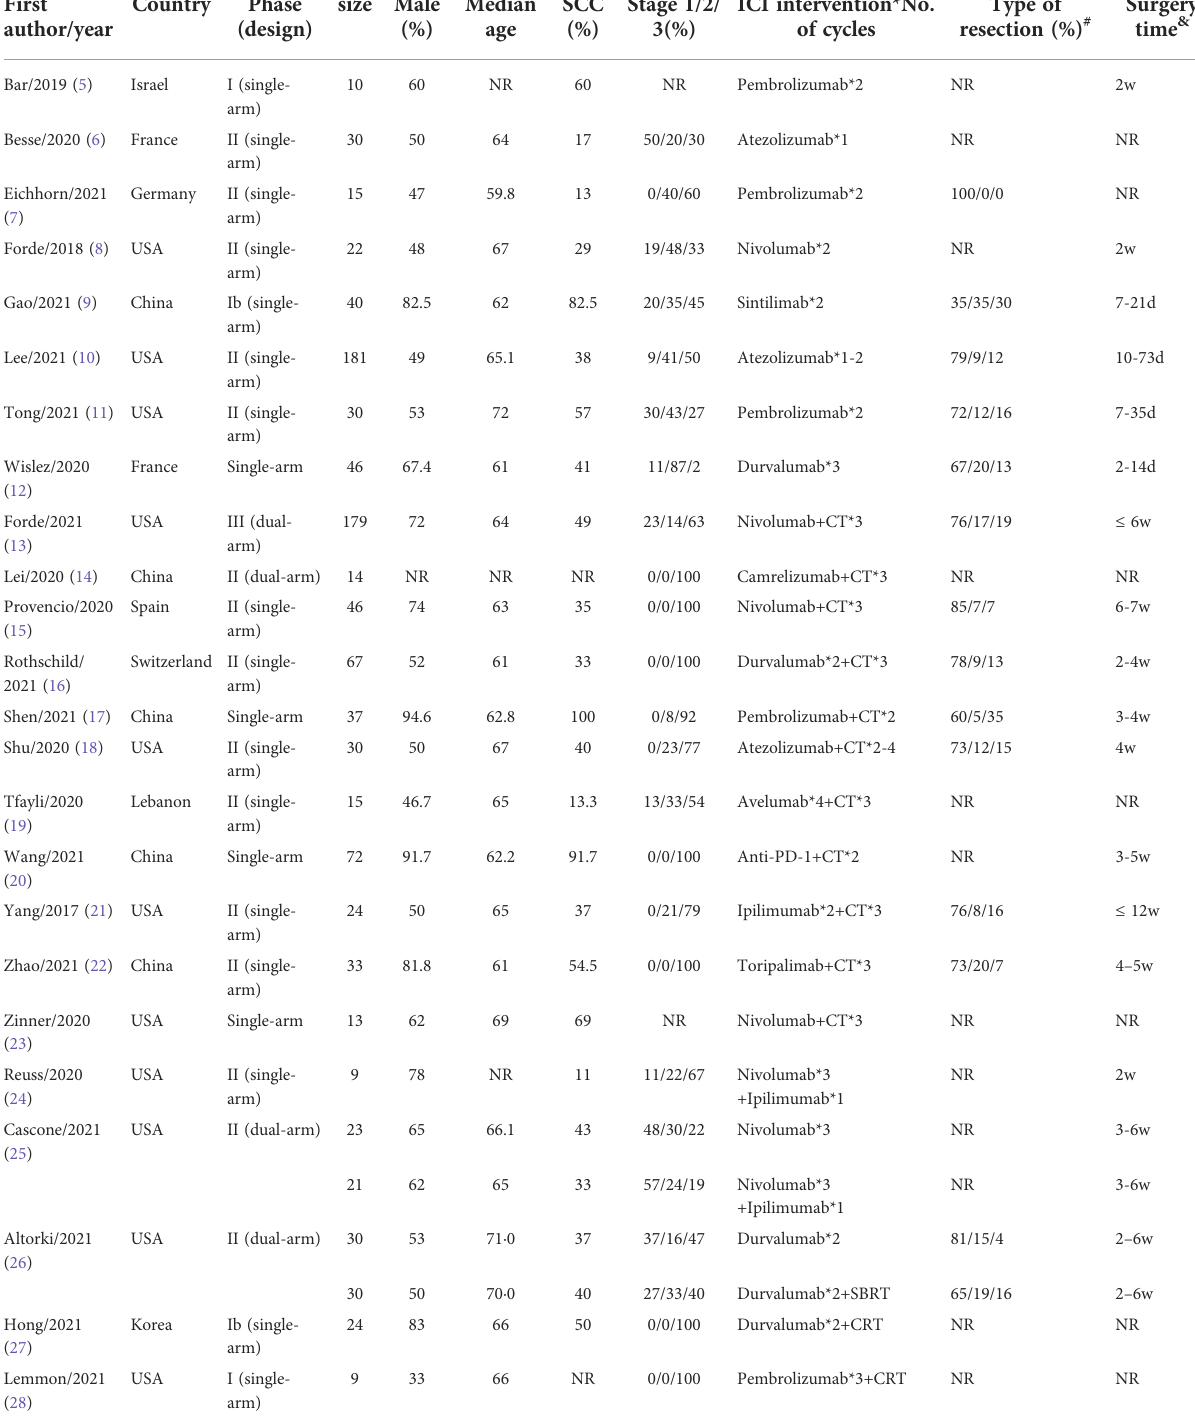
TABLE 1 Characteristics of studies examining neoadjuvant